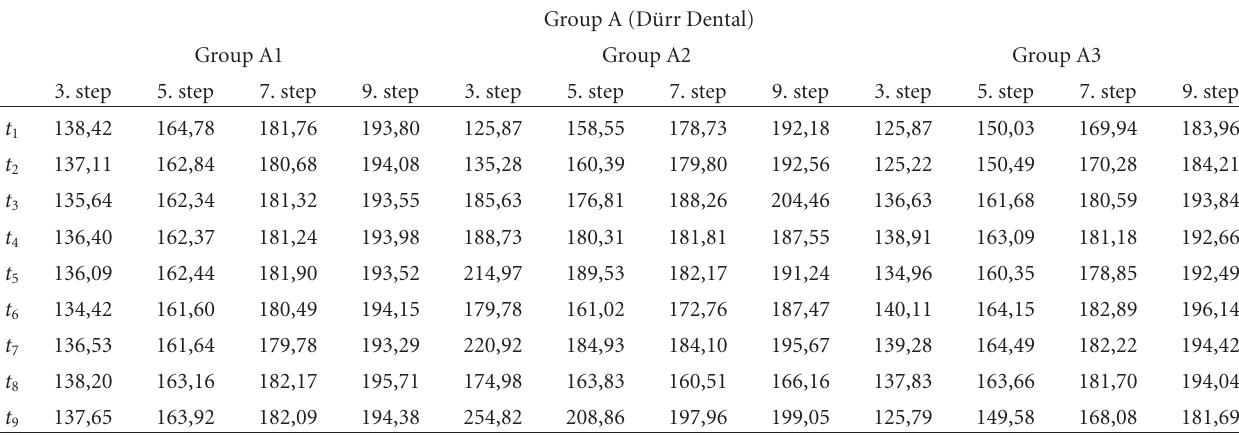
Table 1: The MGVs of the plates for Group A according to delay in scanning time.